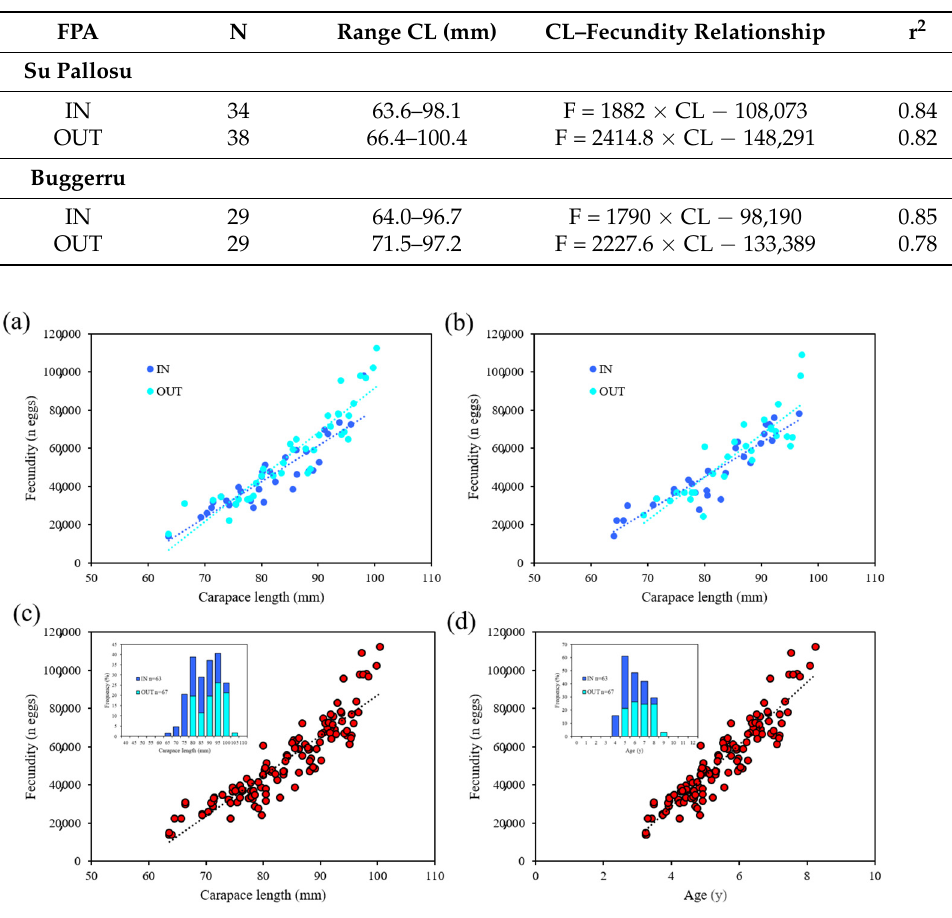
Figure 3. Fecundity–size relationships for Palinurus elephas based on data collected inside (IN) and in the neighbouring commercially fished zones (OUT) of ( a ) the Su Pallosu and ( b ) (Buggerru). Fecundity–size ( c ) and fecundity–age ( d ) relationships based on data collected inside of the two FPAs (Su Pallosu and Buggerru) and in the neighbouring commercially fished zones.